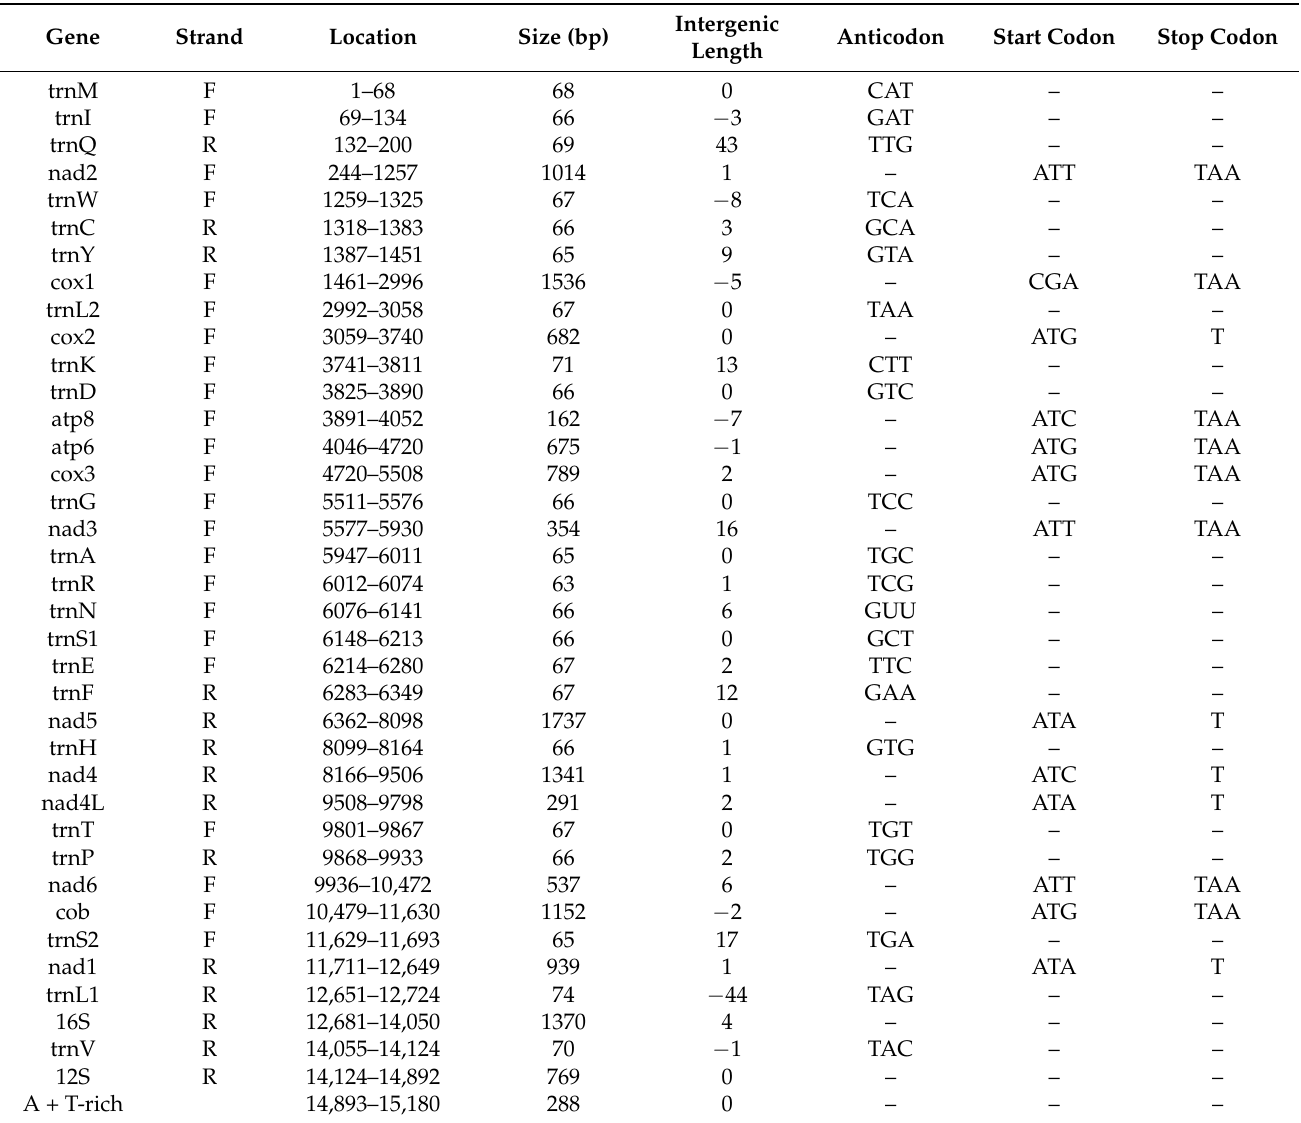
Table 2. Summary of the mitogenome of C. perspectalis .